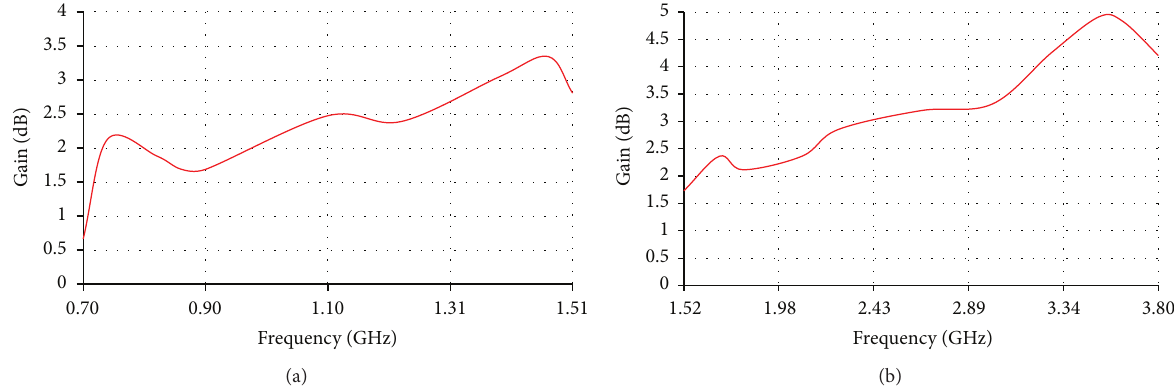
Figure 4: Gain of (a) the low band antenna and (b) the high band antenna.